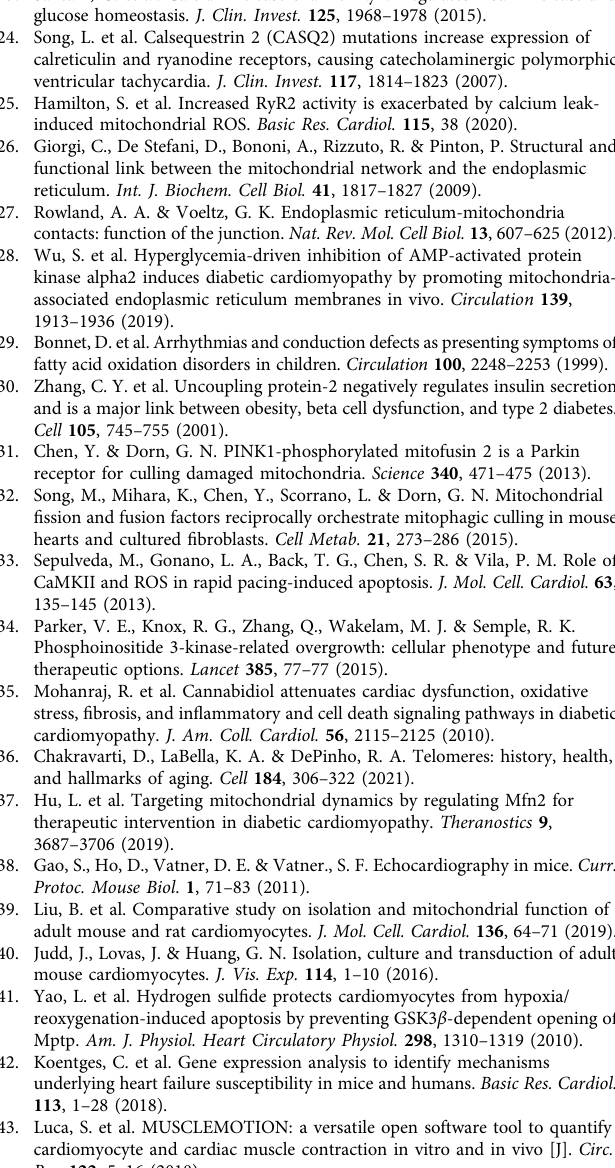
Table S5. Mass spectrometry of hiPSC-CMs data. Table S6. Mass spectrometry of co- immunoprecipitation overexpressed by TECRL in hiPSC-CMs. Supplementary fi gures and all the uncropped blots (Fig. S7) were in the supplementary information fi